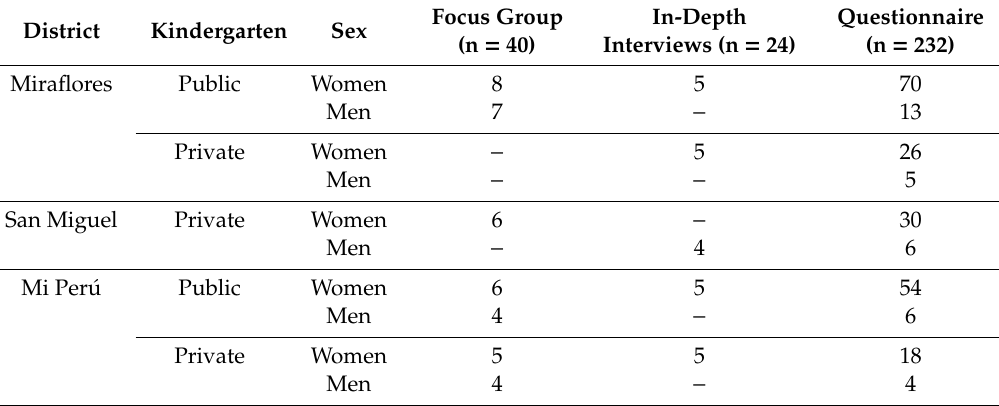
Table 1. Phases and number of the participants.